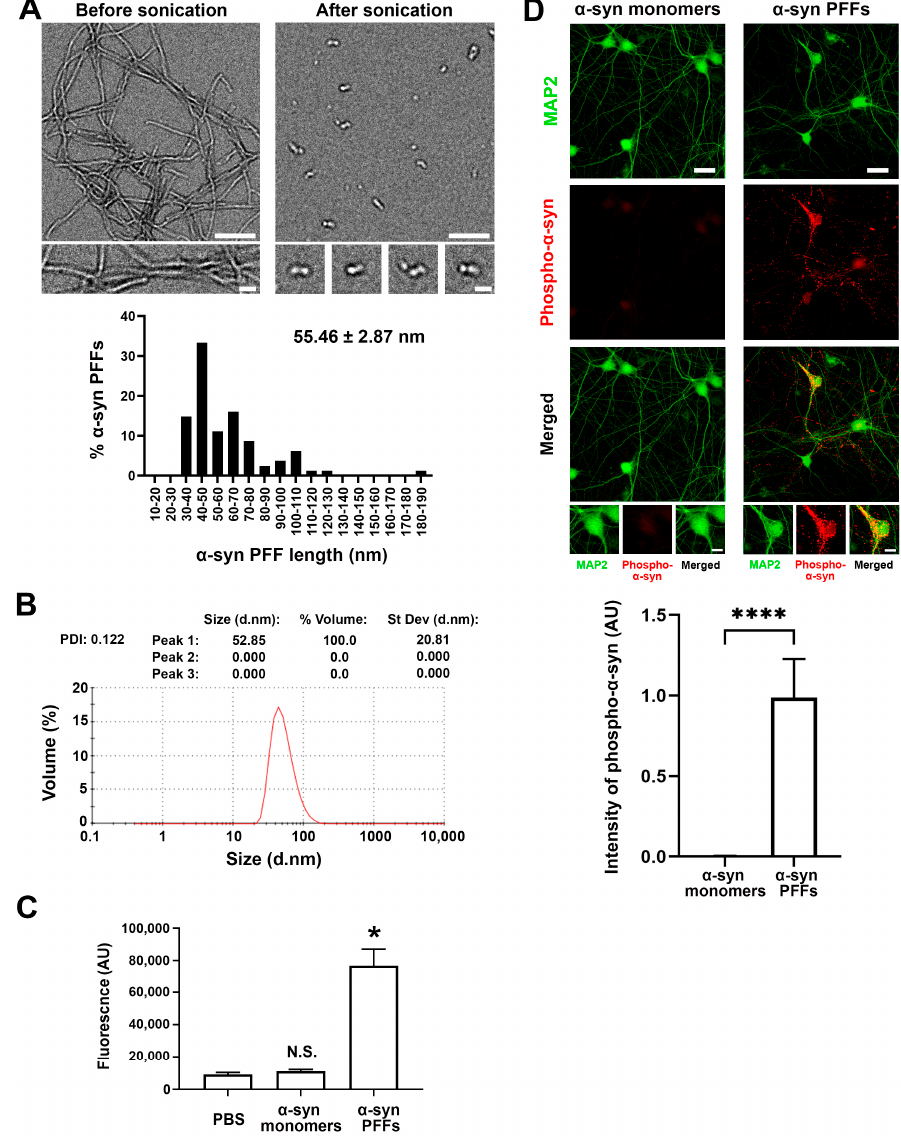
Figure 1. Biophysical characterization of pathological α -synuclein preformed fibrils ( α -syn PFFs). ( A ) Representative electron microscopy (EM) images ( top ) of α -synuclein ( α -syn) proteins after aggregation incubation ( left ) followed by sonication ( right ). The sonicated aggregates were used as α -syn preformed fibrils ( α -syn PFFs) in this study. Histogram ( bottom ) showing the lengths of α -syn PFFs. Most are between 30 and 80 nm (55.46 ± 2.87 nm (mean ± SEM, 81 α -syn PFF particles)). Scale bars: 200 µ m in lower magnification images and 50 µ m in higher magnification images. ( B ) The dynamic light scattering analysis of α -syn PFFs confirms that their average size is 52.85 nm, which is consistent with the above EM analysis, and shows that their polydispersity index (PDI) is 0.122, suggesting that they are relatively homogeneous aggregates. ( C ) Fluorescent quantification using thioflavin-T assays to confirm amyloid β -sheet structures in α -syn PFFs. Kruskal- Wallis one-way ANOVA, p < 0.01. * p < 0.05 and N.S., not significant, compared with PBS by a Dunn’s multiple comparisons test. Data are presented as mean ± SEM. ( n = 2 samples for PBS and α -syn monomers and 6 samples for α -syn PFFs). ( D ) α -syn PFFs induce hyperphosphorylation of endogenous α -synuclein in the hippocampal neuron cultures. Hippocampal cultured neurons were treated with α -syn PFFs (2.5 µ g/mL [174 nM monomer equivalent]) or α -syn monomers (2.5 µ g/mL) at 7 days in vitro (DIV). The cultures were maintained until 14 DIV and then immunostained for phospho- α -synuclein (red) and MAP2 (green), the dendrite marker. Treatment with α -syn PFFs, but